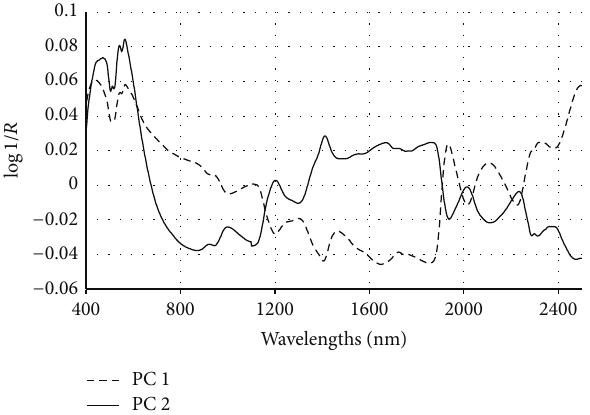
Figure 8: Loading-vector plot of first two principal components corresponding to the dataset constructed from the 117 maize